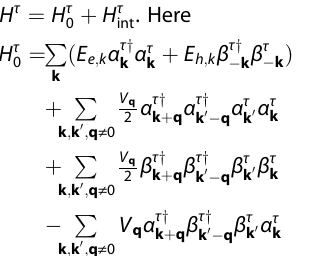
= E 2 calculated theoretically (th.) pump ex ) and BS ( Δ E (cid:2) ) shifts of A ð B Þ A ð B Þ